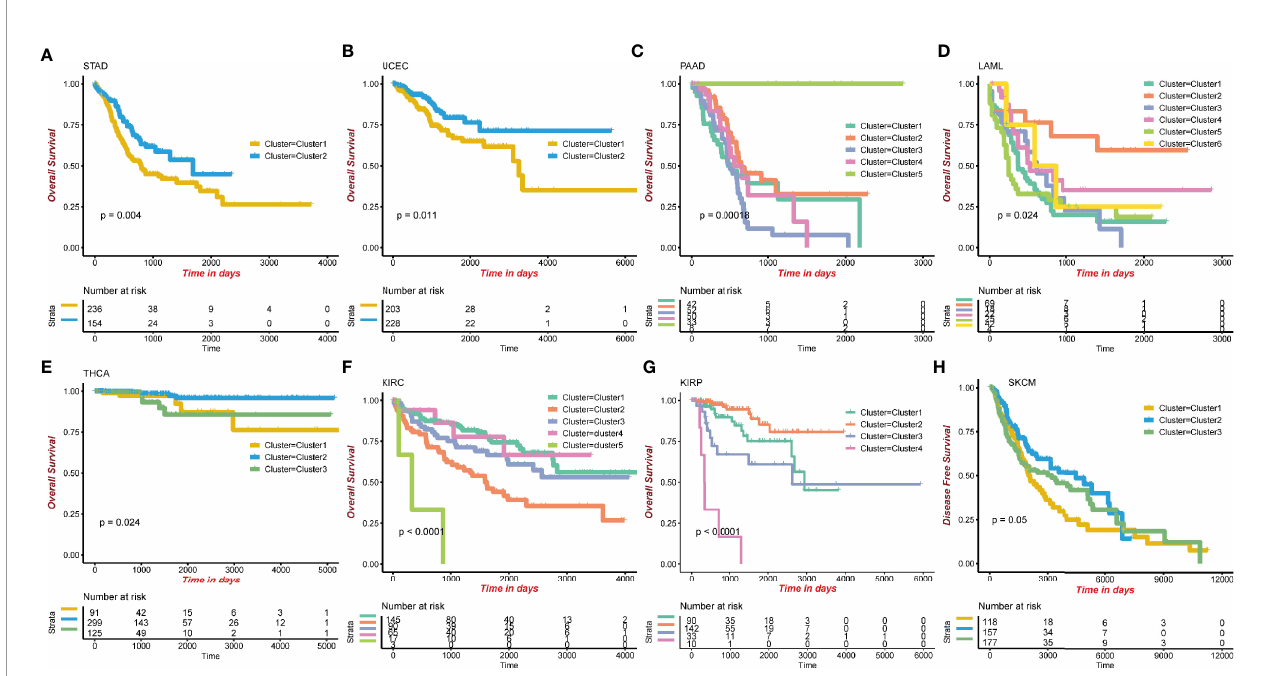
FIGURE 4 | Eight cancer types showing signi fi cant outcomes in TCGA pan-cancer survival analysis using consensus cluster. (A) STAD, Stomach adenocarcinoma. (B) UCEC, Uterine Corpus Endometrial Carcinoma. (C) PAAD, Pancreatic adenocarcinoma. (D) LAML, Acute Myeloid Leukemia. (E) THCA, Thyroid carcinoma. (F) KIRC, Kidney renal clear cell carcinoma. (G) KIRP, Kidney renal papillary cell carcinoma. (H) SKCM, Skin Cutaneous